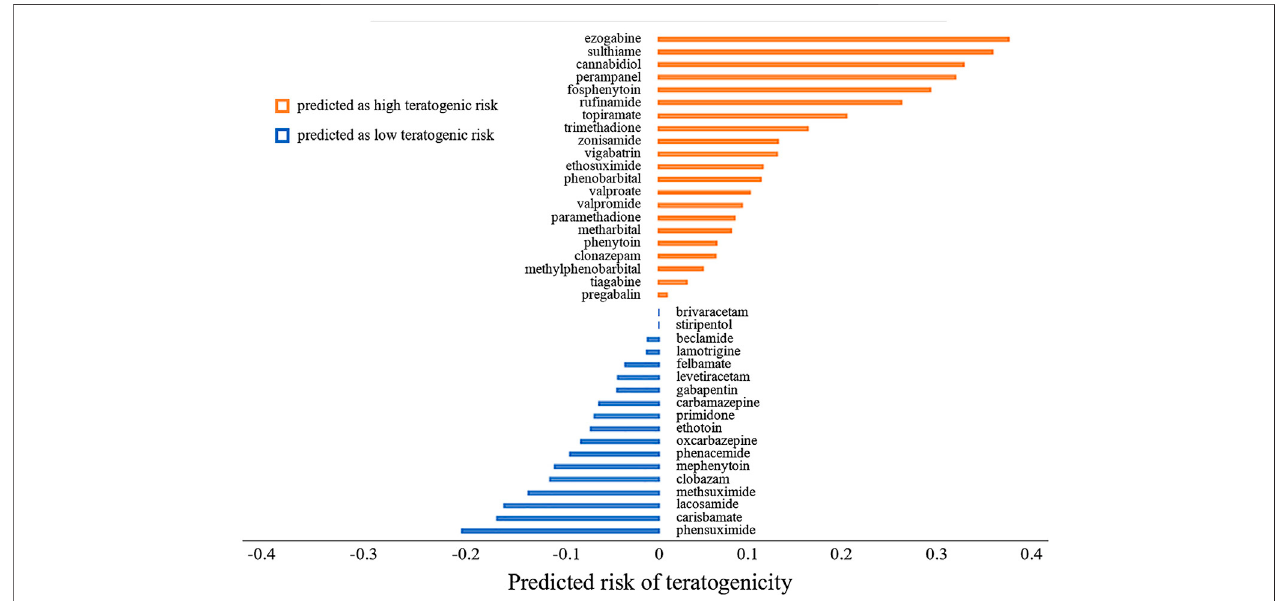
FIGURE 4 | The predicted risk of teratogenicity of 39 antiseizure medications. The antiseizure medications were ranked by their predicted probabilities in descendingorder.Thehigherthepredictedprobabilityvalueis,thehighertheteratogenicriskis.Wetook0.5asacutoff.Adrugwithpredictedprobabilitylargerthan0.5 was predicted as high teratogenic risk, otherwise it was predicted as low teratogenic risk. For the sake of demonstration, we subtracted 0.5 from the predicted probability of each drug before plotting.